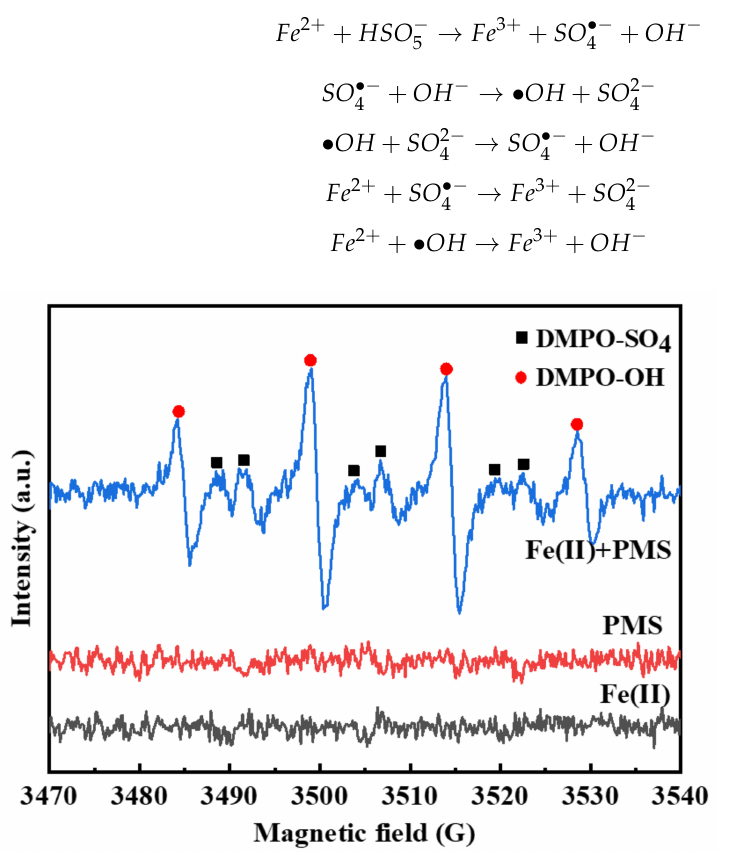
Figure 8. EPR spectra of Fe(II), PMS, and Fe(II)-activated PMS